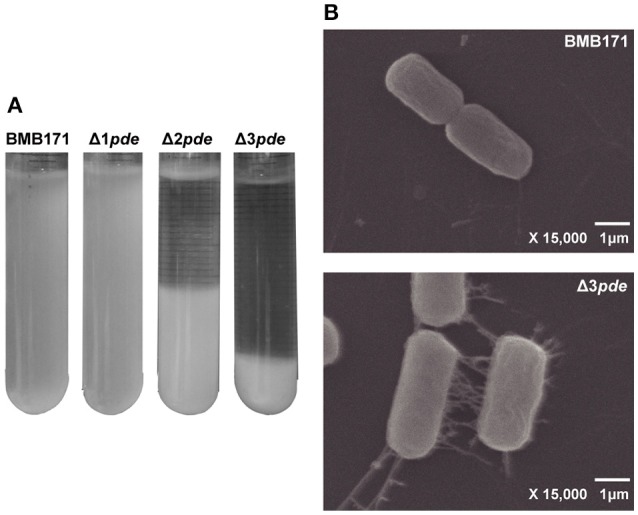
Degree of cell-cell aggregation is linked to the increasing intracellular c-di-GMP level in B. thuringiensis. (A) Comparison of cell-cell aggregation rate in BMB171, Δ1pde, Δ2pde, and Δ3pde. (B) SEM photograph (× 15,000) of BMB171 and Δ3pde during cell-cell aggregation assay. Many fibers were found to interconnect the cells in the Δ3pde mutant.